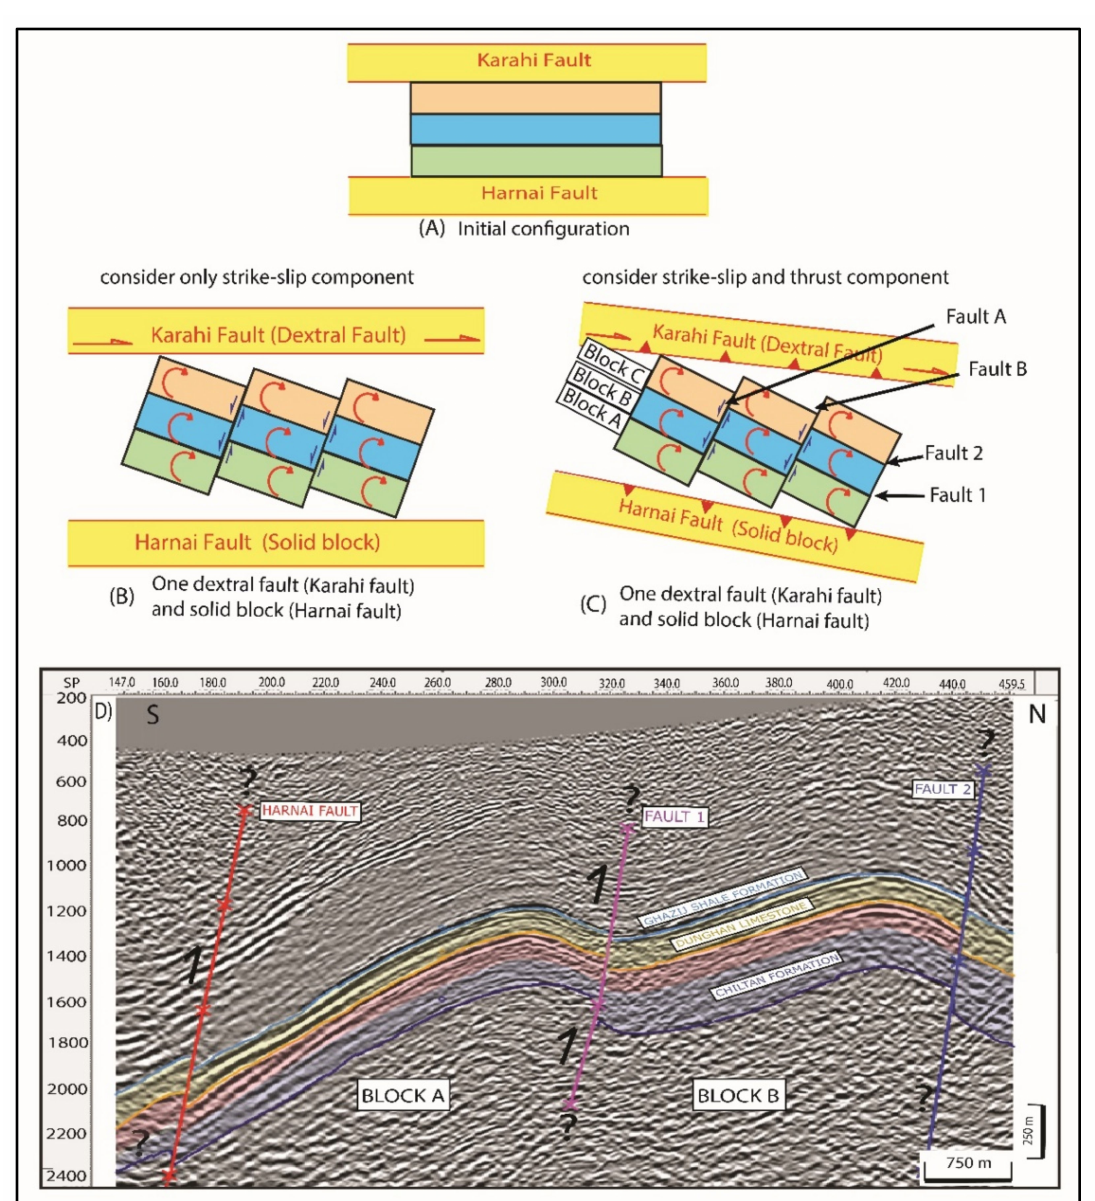
Figure 18. A proposed kinematic model with 2D seismic interpretation. ( A ) Initial bookshelf model, ( B ) considering only strike-slip component ( C ) considering strike-slip and thrust component ( D ) seismic line BOL98-11 from Figure